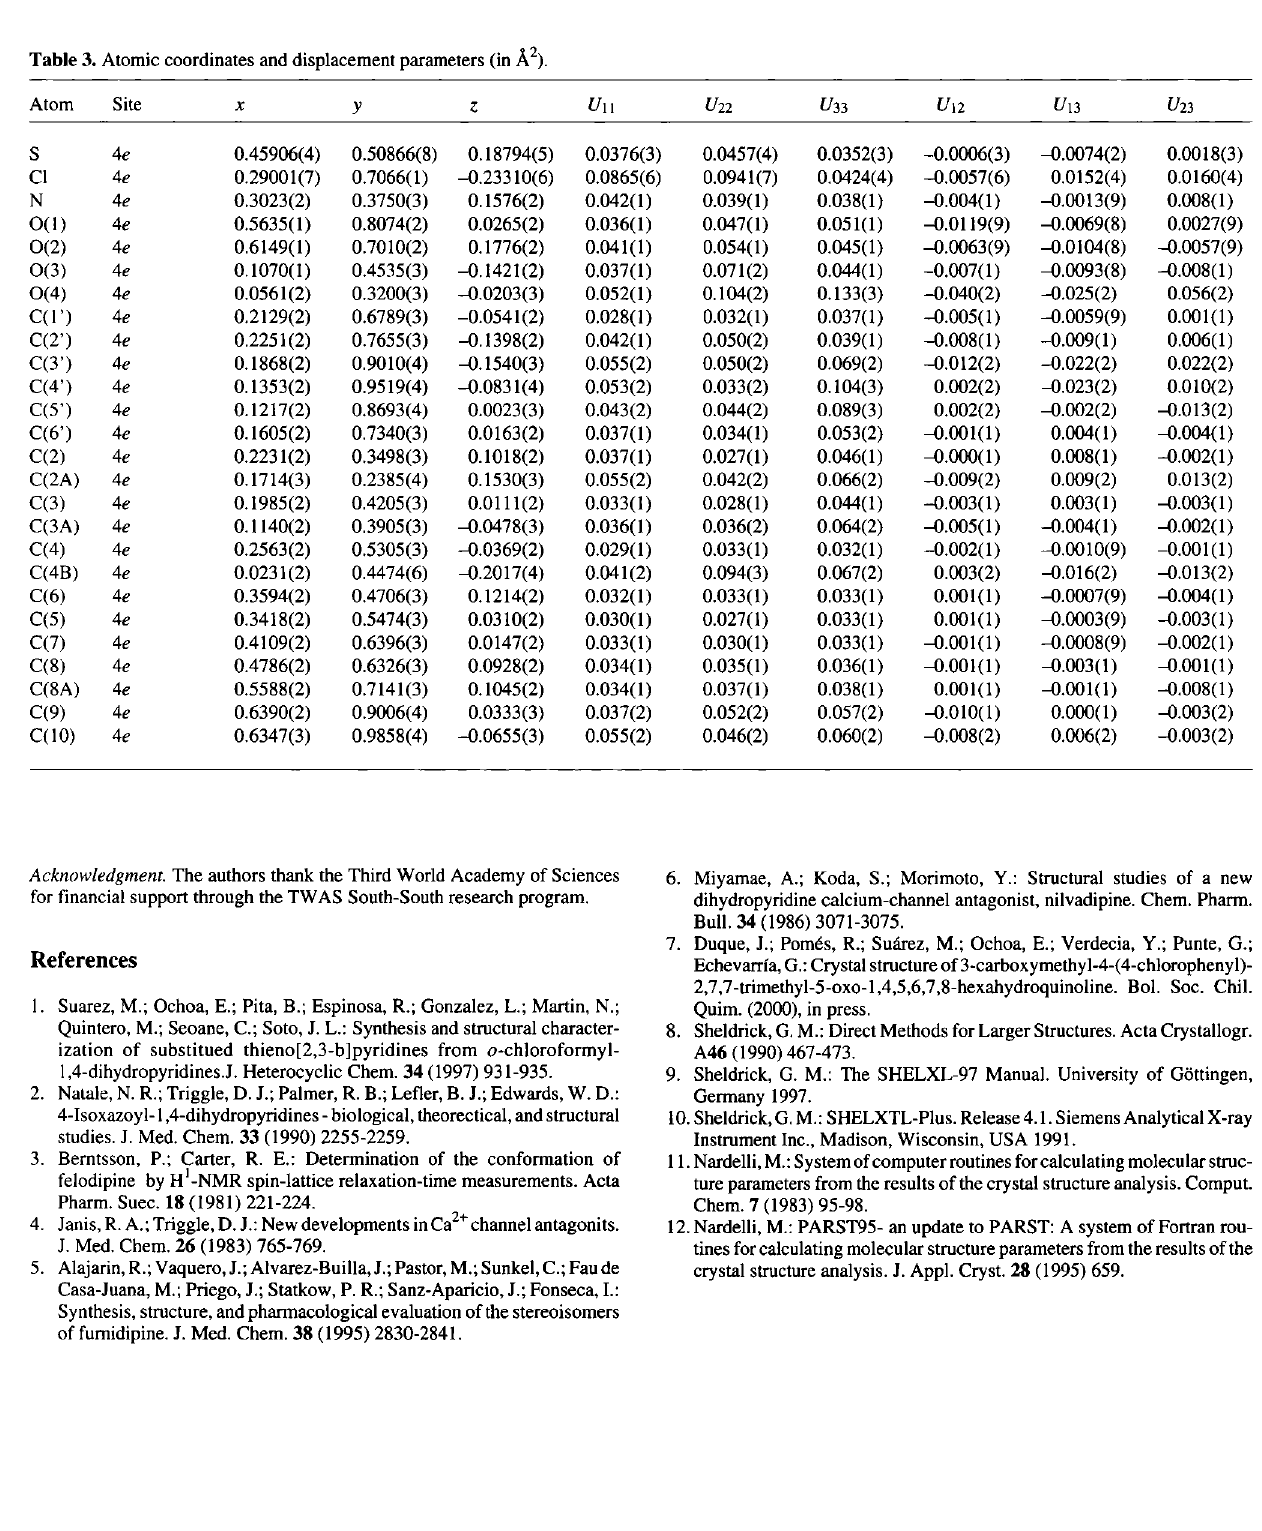
Table 3. Atomic coordinates and displacement parameters (in Ä 2